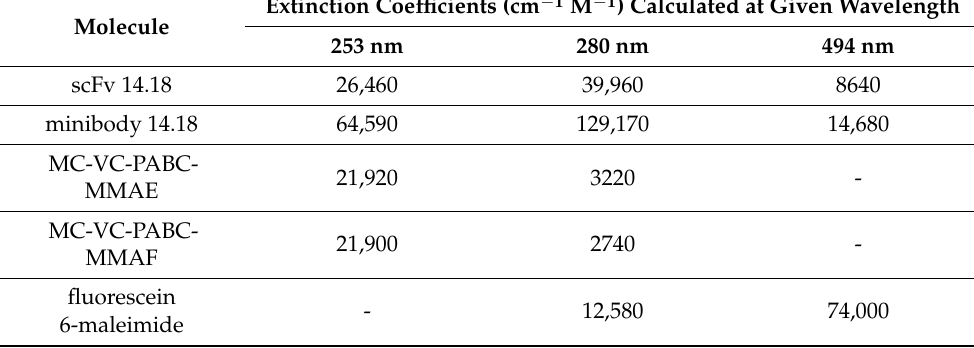
Table 1. Extinction coeffficients employed for calculation of the drug-to-antibody ratios. Extinction Coefficients (cm − 1 M − 1 ) Calculated at Given Wavelength Molecule 253